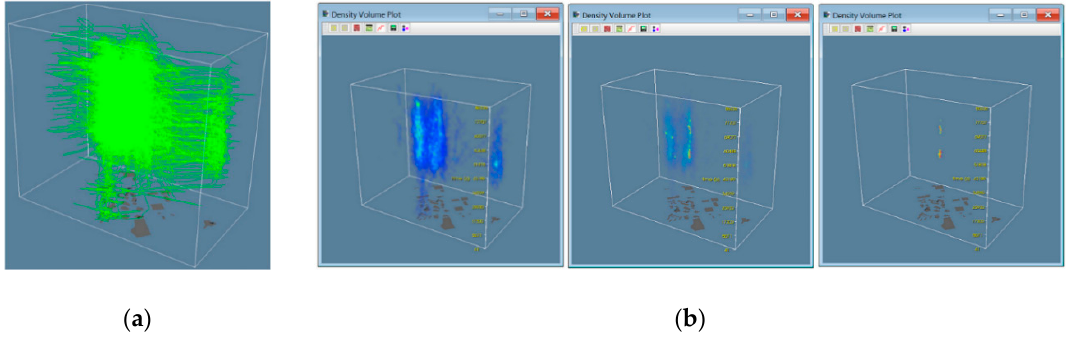
Figure 11. Applications of detecting epidemic-disease risk with: ( a ) space–time cube; and ( b ) density map [41].